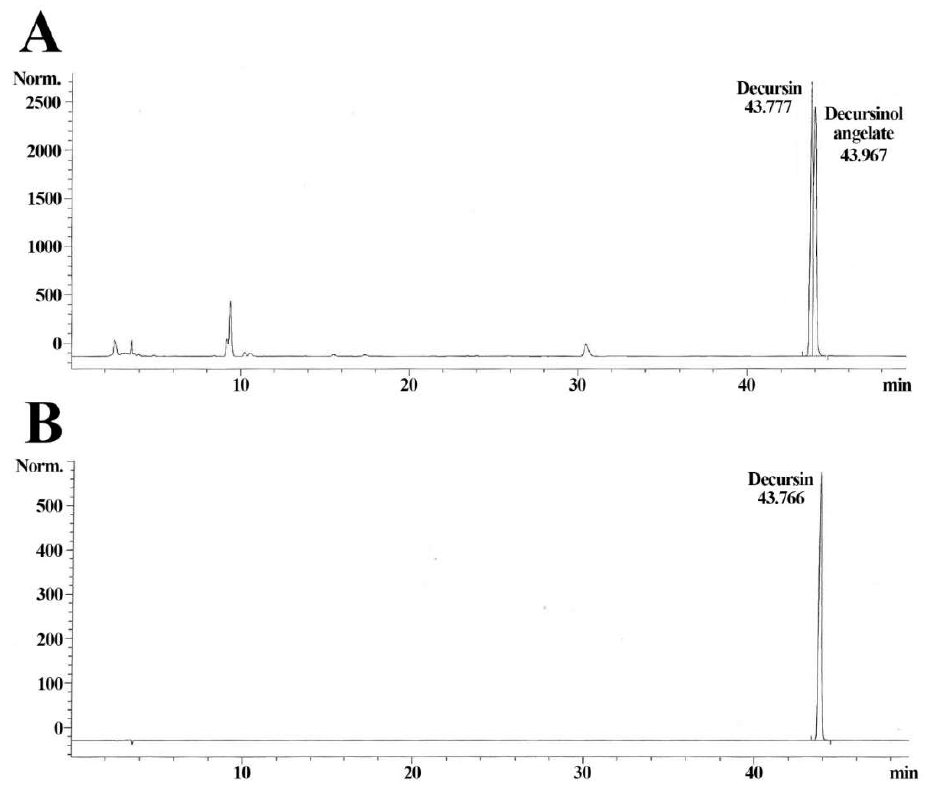
Figure 1. Representative HPLC chromatograms of AGN extract ( A ) and standard decursin ( B ). Retention times of the AGN extract are 43.777 min (decursin) and 43.967 (decursinol angelate) respectively, and the retention time of the standard decursin is 43.766 min.